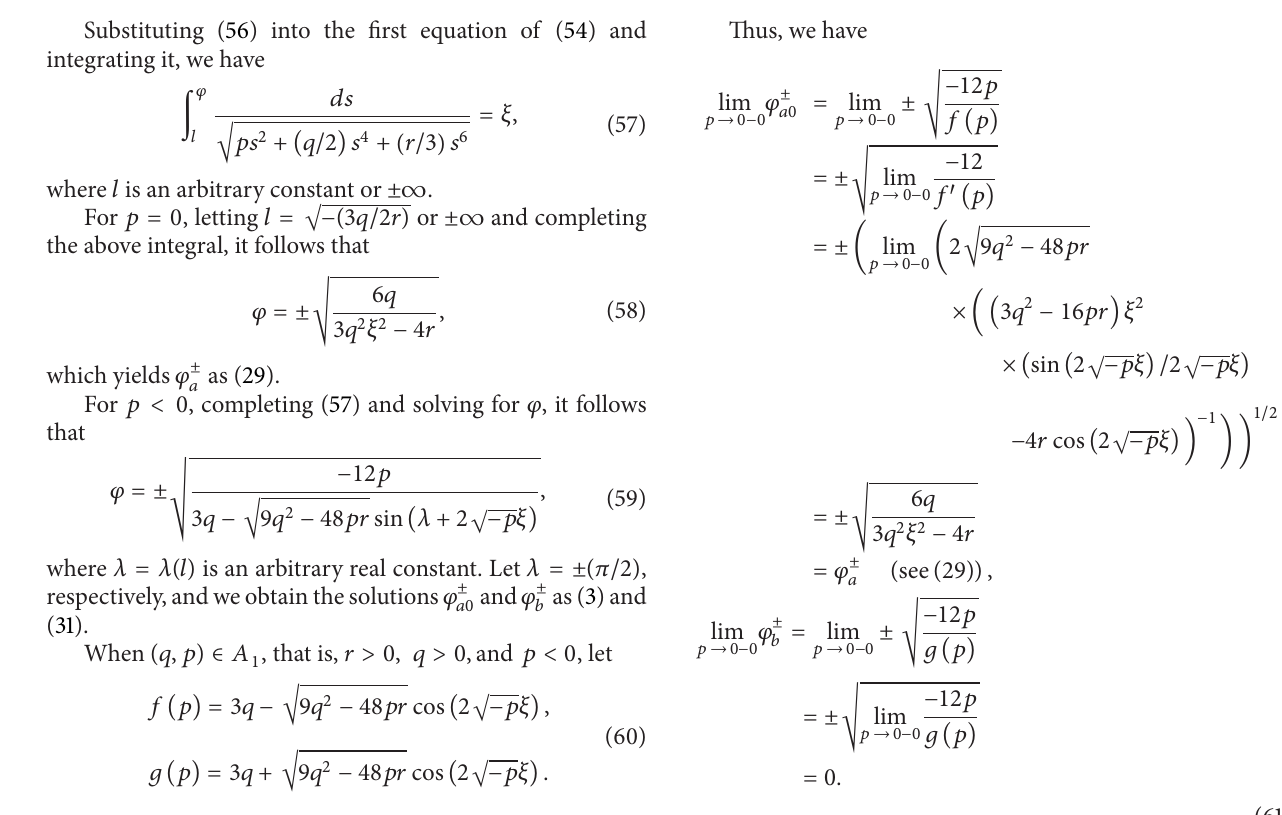
: 𝑝 = 3𝑞 2 /16𝑟 = 3 and (a) 𝑝 = 3 + 10 −1 , (b) 2